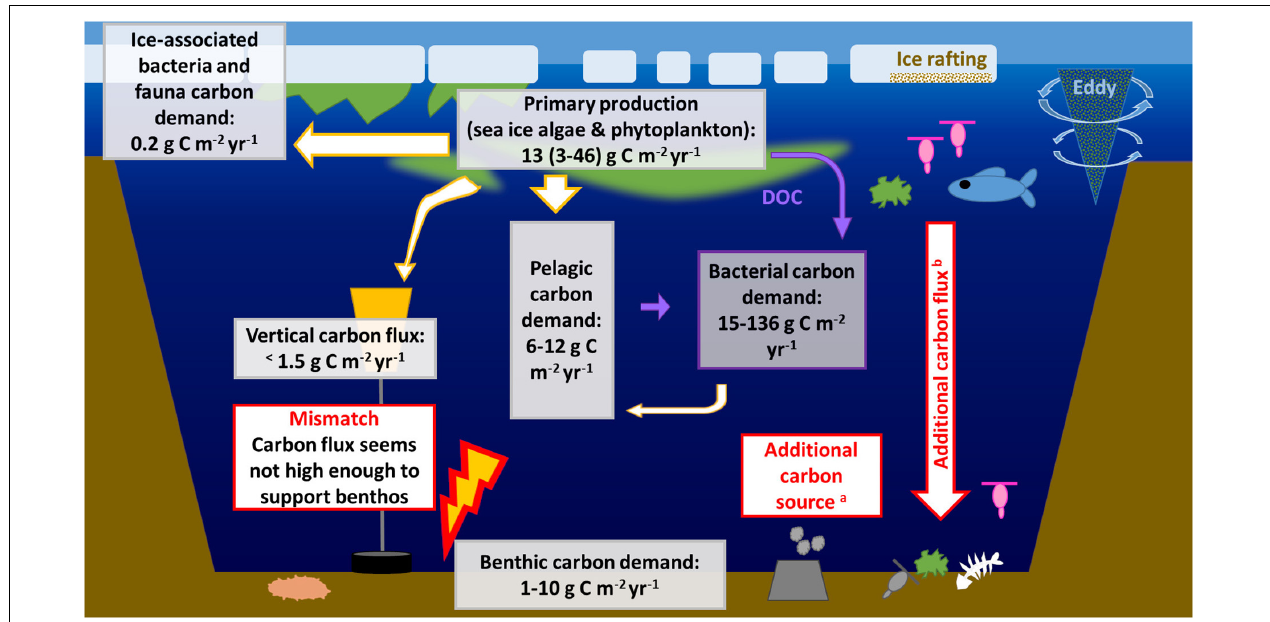
FIGURE 4 | Carbon budget of the central Arctic Ocean basin including the annual mean production, annual ice-associated, pelagic, and benthic carbon demand as well as the vertical carbon flux. The white arrows with orange edge represent particulate organic carbon flow between producers and consumers. The microbial loop and bacterial DOC demand (purple arrows) are not discussed in detail in this work,but are included here to show a complete picture. a Chemosynthesis may be a local, benthic carbon source. b Additional, and so far largely not quantified carbon sources are advection, export of large, fast-sinking algal aggregates, migrating or dead copepods, and large food